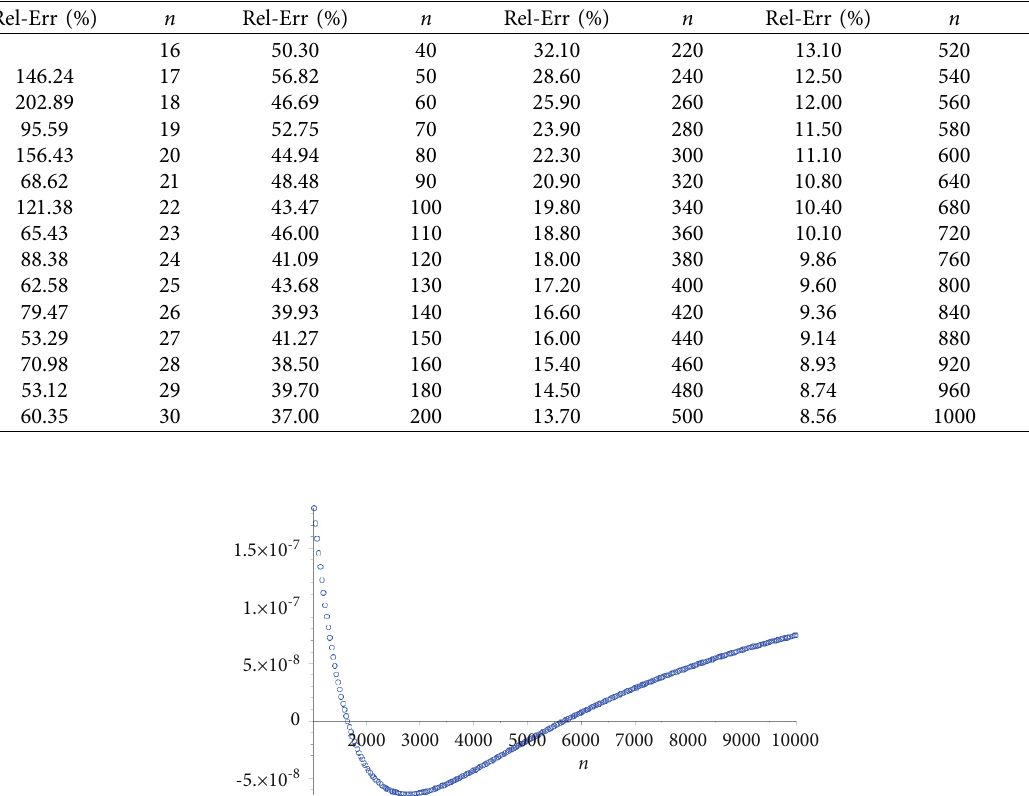
Table 11: The relative error of I